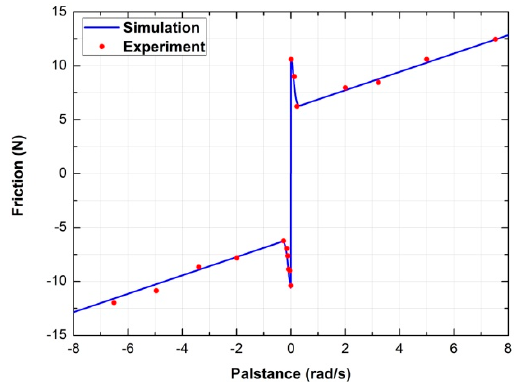
Figure 18. Curve of the friction force.